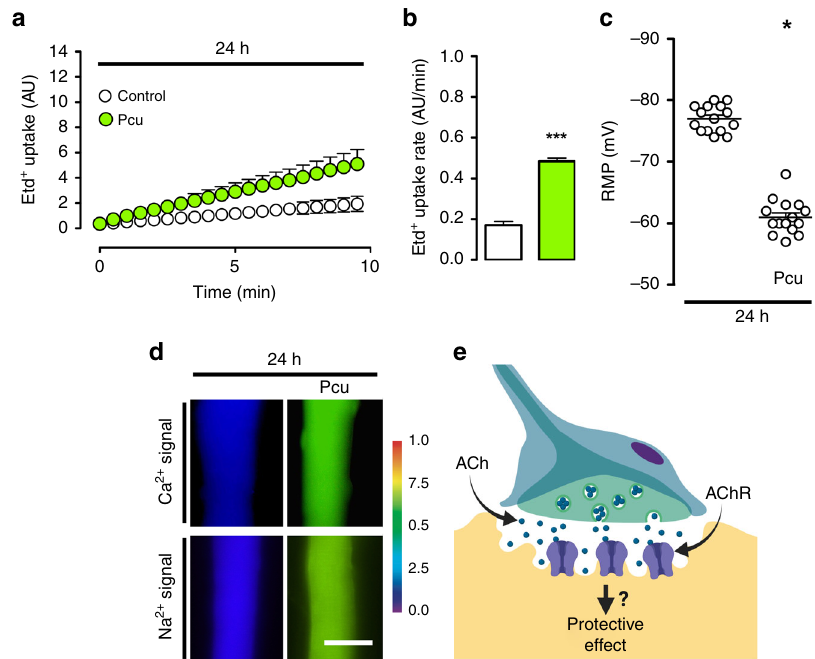
Fig. 4 The activity of nicotinic acetylcholine receptor (nAChR) prevents atrophy of skeletal myo fi bers. Primary cultures of myo fi bers from fl exor digitorum brevis (FDB) muscle were used. a Membrane permeability was measured in time-lapse experiments evaluating ethidium (Etd + ) uptake performed after 24 h of culture. Myo fi bers were cultured under control conditions (white), or treated with 15 µ M pancuronium (Pcu; green). b N = 4; six myo fi bers recorded in each independent experiment, each value is the mean ± SEM. *** p < 0.001, for effect of Pcu compared with Control by Student ’ s t test. c Resting membrane potential (RMP) was evaluated at 24 h of culture. Myo fi bers were cultured under control conditions or after treatment with 15 µ M Pcu. N = 5; at least 20 myo fi bers recorded in each independent experiment. * p < 0.05, for effect of Pcu compared with Control by Student ’ s t test. d Upper images, intracellular Ca 2 + signals (340/380) and, lower images, Na + signals were recorded at 24 h of culture with FURA-2 and SBFI, respectively. The colored scale to the right of the panels depicts the color shifts from blue to green as the dye is bound to Ca 2 + or Na + . Parallel cultures were treated with 15 µ M Pcu and 24 later the Ca 2 + and Na + signals were evaluated. Scale bar: 50 µ m. e Proposed